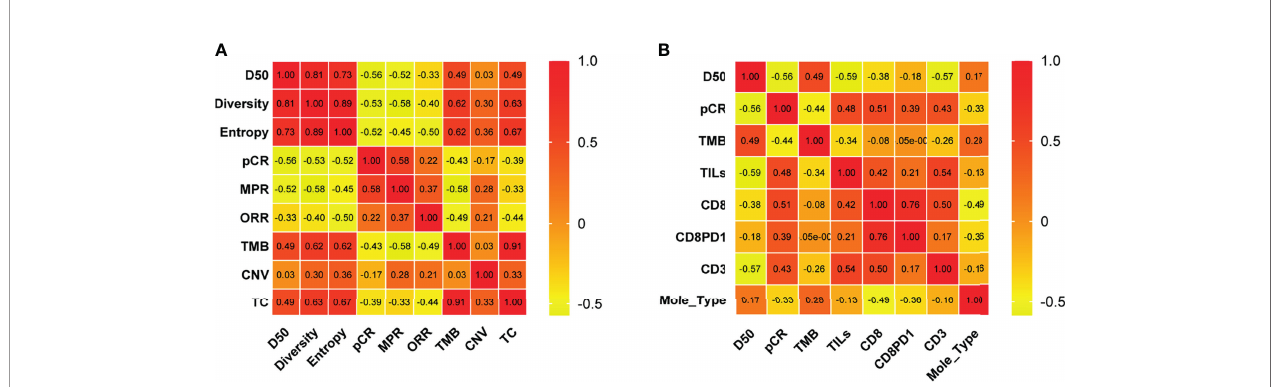
FIGURE 2 | Correlation of molecular and clinical response variables. Correlation coef fi cients between two variables among TCR D50, Diversity index, Entropy, pCR, MPR, ORR, TMB, CNV, and T cell percentages in tissues of pre-NAC samples (A) and among D50, pCR, TMB, TILs, CD8, CD8PD1, CD3 and molecular types (B) were listed. The number in the color chart is the correlation coef fi cient. pCR, pathologic complete response; MPR, major pathological response; ORR, Objective Response Rate; TMB, tumor mutational burden; CNV, Copy number variations; TC, TMB and CNV; Mole_Type, Molecular